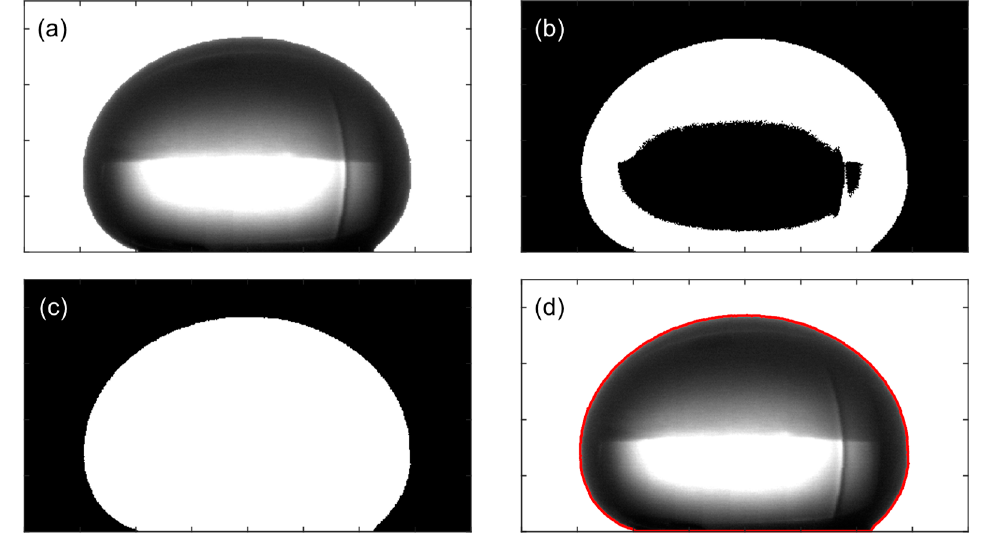
Figure 6. Droplet side-view configuration optical image processing of a superhydrophobic droplet. ( a ) grayscale; ( b ) Otsu threshold; ( c ) binarized and filled; ( d ) boundary traced.